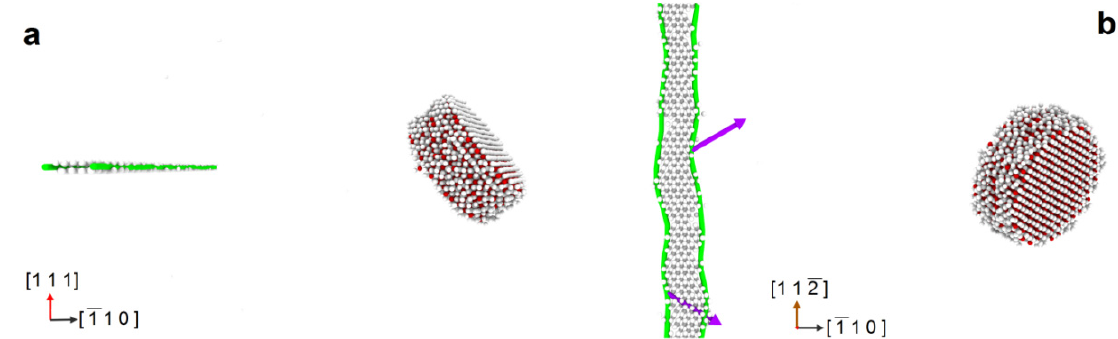
Figure 2. Dislocation and θ ’ precipitate of 5 nm diameter in MD system after energy minimization. ( a )—view along [112] direction, ( b )—view along [111] . Atoms with a centrosymmetry parameter more than 5 square angstroms are depicted. Aluminum atoms are colored in gray, copper atoms are red. Shockley partial dislocations are colored in green.